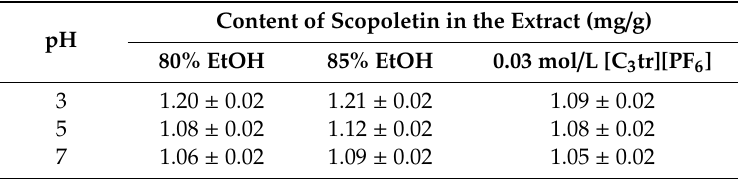
Table 4. E ff ect of di ff erent extractants on content of